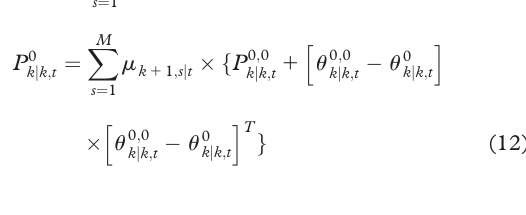
ffiffiffiffiffiffiffiffiffiffiffiffiffiffiffi p 0 : 01 = 2